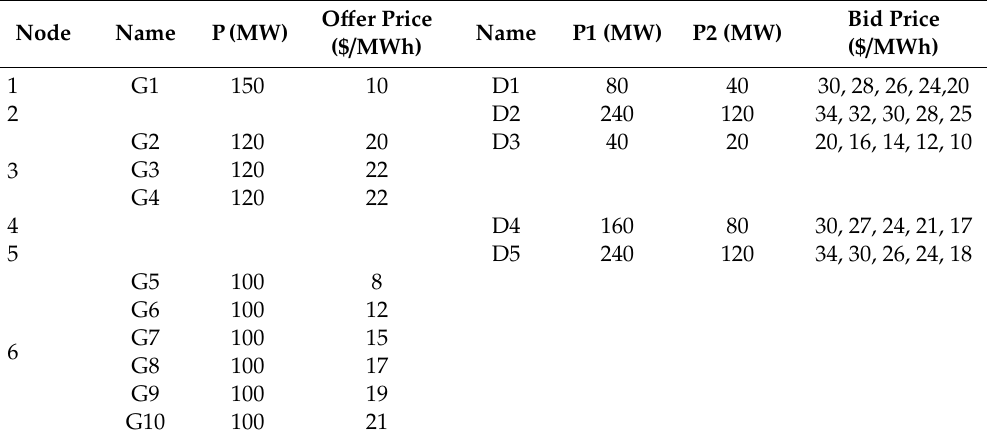
Table 1. Demand and generator restrictions.